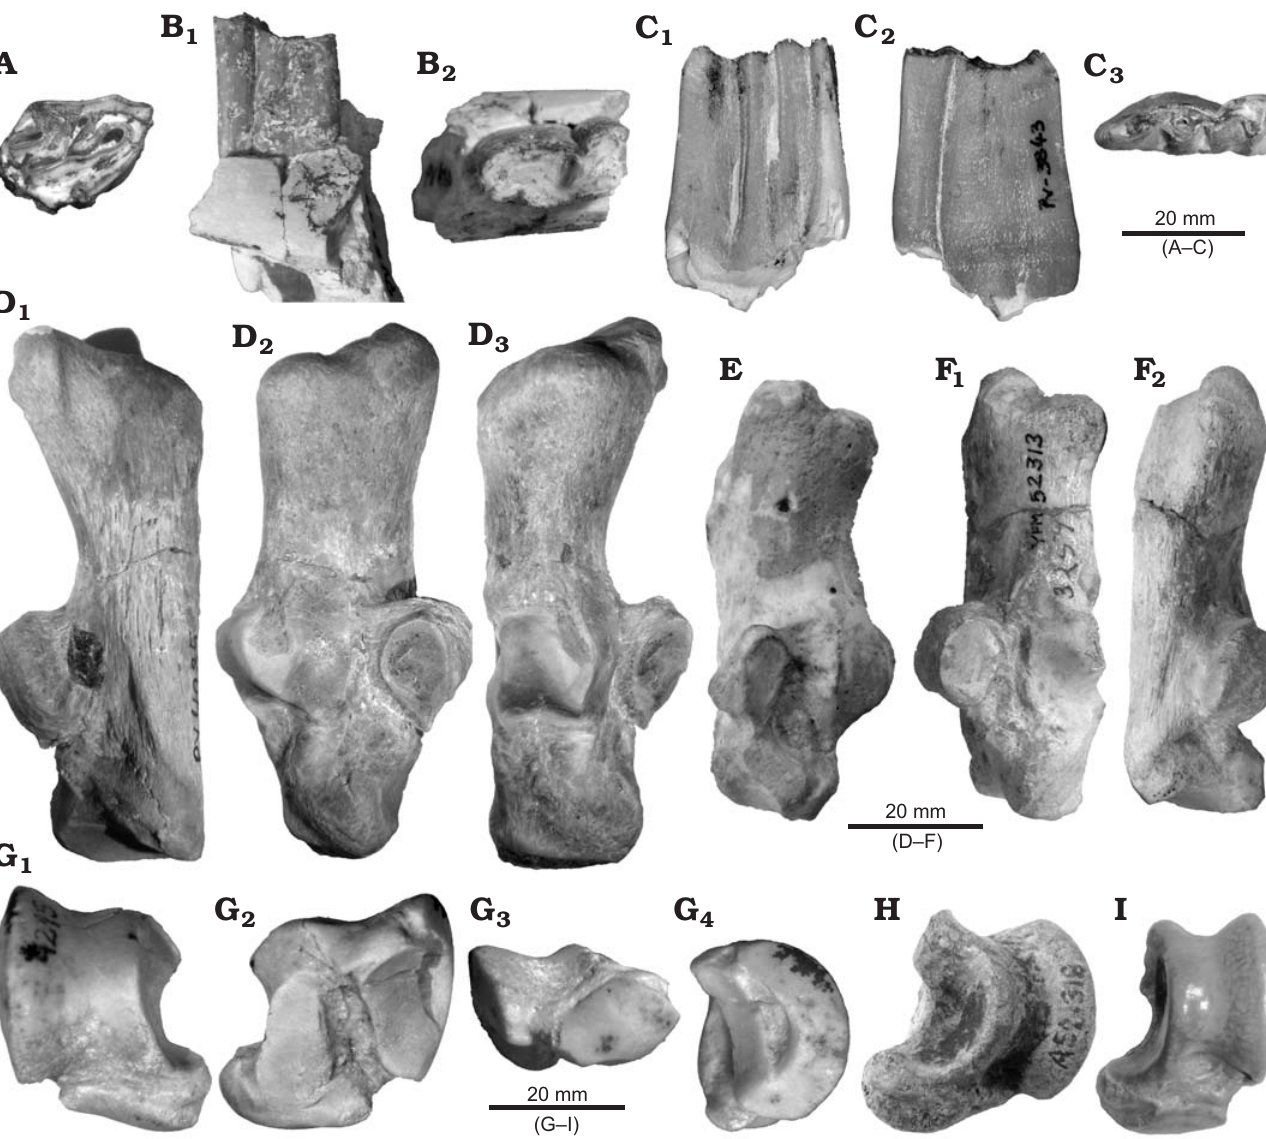
Fig. 2. Toxodontian notoungulates from South America. A – D . Proadinotherium sp. from Quebrada Fiera, Mendoza, Argentina; Deseadan SALMA (late Oligocene). A . MCNAM-PV 4238, right M2, occlusal view. B . MCNAM-PV 4960, left m2, labial (B 1 ) and occlusal (B 2 ) views. C . MCNAM-PV 3843, left m3, lingual (C 1 ), labial (C 2 ), and occlusal (C 3 ) views. D . MCNAM-PV 4085, right calcaneum, posterior (D 1 ), medial (D 2 ), and anterior (D 3 ) views. E . Proadinotherium muensteri Ameghino, 1902 from Colhue Huapi lake, Chubut, Argentina; Colhuehuapian SALMA (early Miocene), MACN Pv-17576 (cast), left calcaneum, medial view. F . Rynchippus equinus Ameghino, 1897 (Notohippidae) from Salla, Bolivia; Deseadan SALMA (late Oligocene), YPM VP-52313, left calcaneum, anterior (F 1 ) and posterior (F 2 ) views. G . Proadinotherium sp. from Quebrada Fiera, Mendoza, Argentina; Deseadan SALMA (late Oligocene), MCNAM-PV 4215, right astragalus, anterior (G 1 ), posterior (G 2 ), distal (G 3 ), and lateral (G 4 ) views. H . Proadinotherium leptognathum Ameghino, 1894 from Santa Cruz, Argentina; Deseadan SALMA (late Oligocene), MACN A 12319, left astragalus, anterior view. I . “ Morphippus im- bricatus ” Ameghino, 1897 (Notohippidae) from Sarmiento Formation, Chubut, Argentina; Deseadan SALMA (late Oligocene), MACN A 12100, left astragalus, anterior facets. The tuber is relatively short (APD) and wide, with its posteromedial area projecting both medially and proxi- mally. There is a well-marked posteromedial depression on the tuber corresponding to the tendinous sulcus (Fig. 2D ), 1 which does not extend on the proximal face. The sustentac- ulum is short and the sustentacular facet is subelliptic and Table 1), Proadinotherium sp. (e.g., YPM VP-25075) and Adinotherium (e.g., MACN 2100, MACN 8515; Table 1), but flat, placed at a rather vertical plane (Fig. 2D ). The ectal 3 they share the general outline and disposition of the articular facet is high and narrow, subdivided into two main flattened